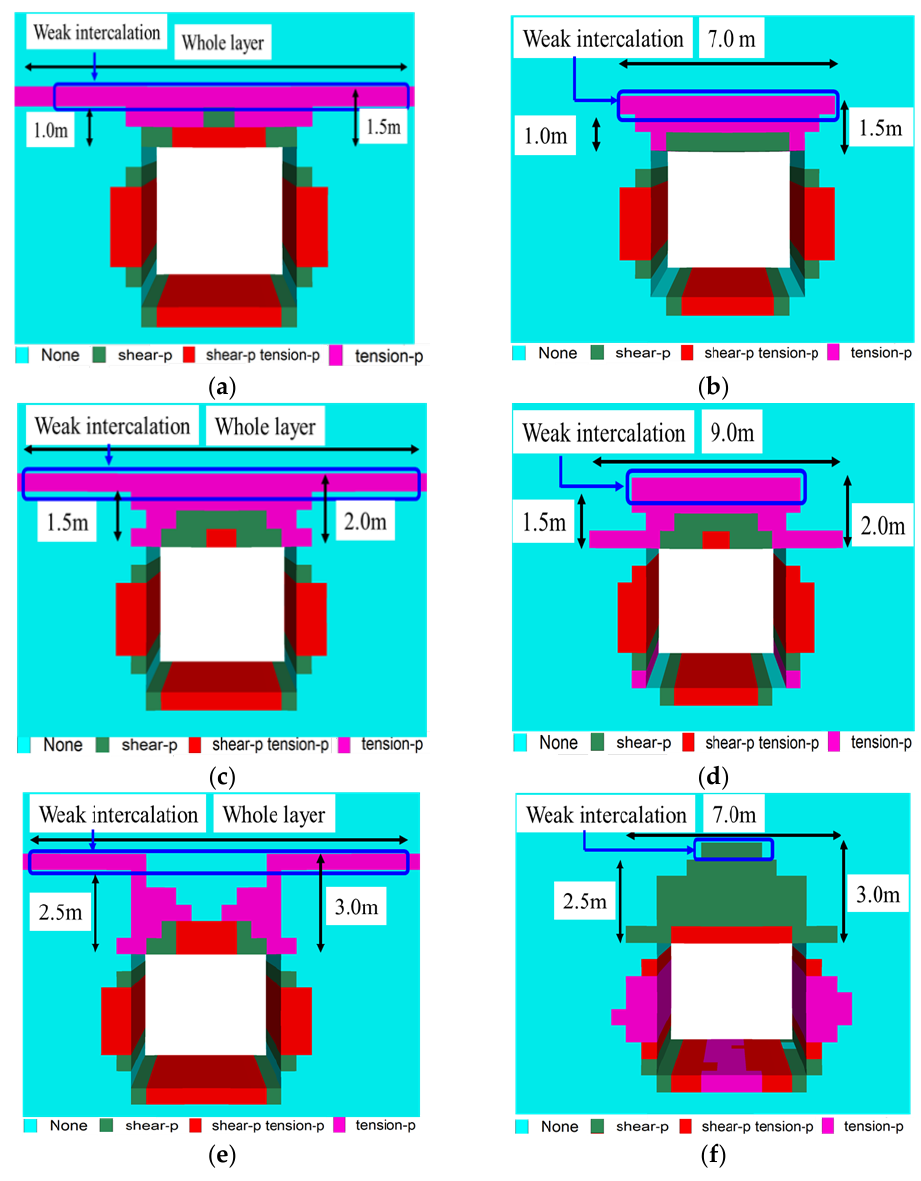
Figure 8. Distribution of the Plastic Zone of Roof in schemes I and II. ( a ) Scheme I — 0.5 times L . ( b ) Scheme II — 0.5 times L . ( c ) Scheme I — 0.8 times L . ( d ) Scheme II — 0.8 times L . ( e ) Scheme I — 1.0 times L . ( f ) Scheme II — 1.0 times L .